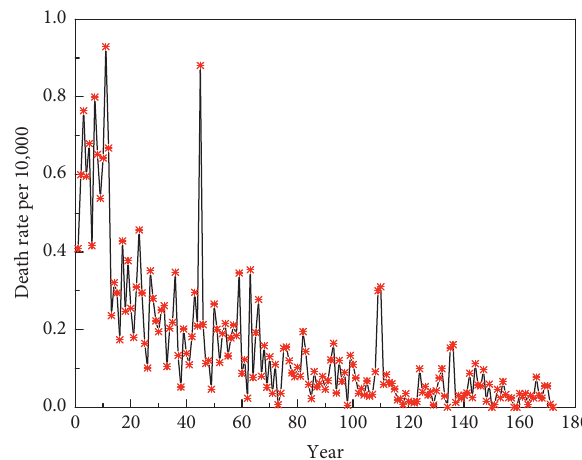
Figure 2: Time series chart of death rate per 10,000 in mining safety